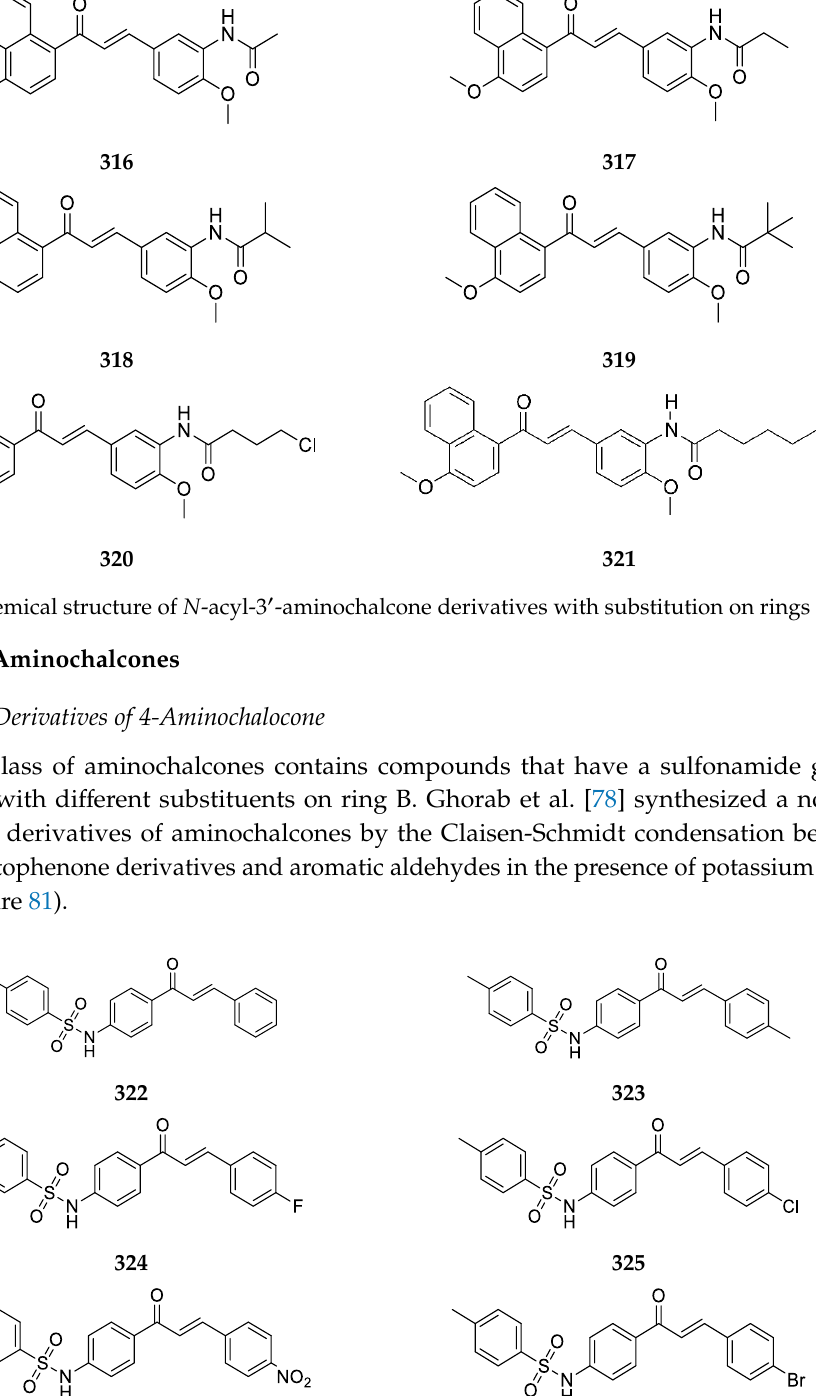
Figure 81. Chemical structure of sulfonamide-4-aminochalcone derivatives with substitution on ring B.